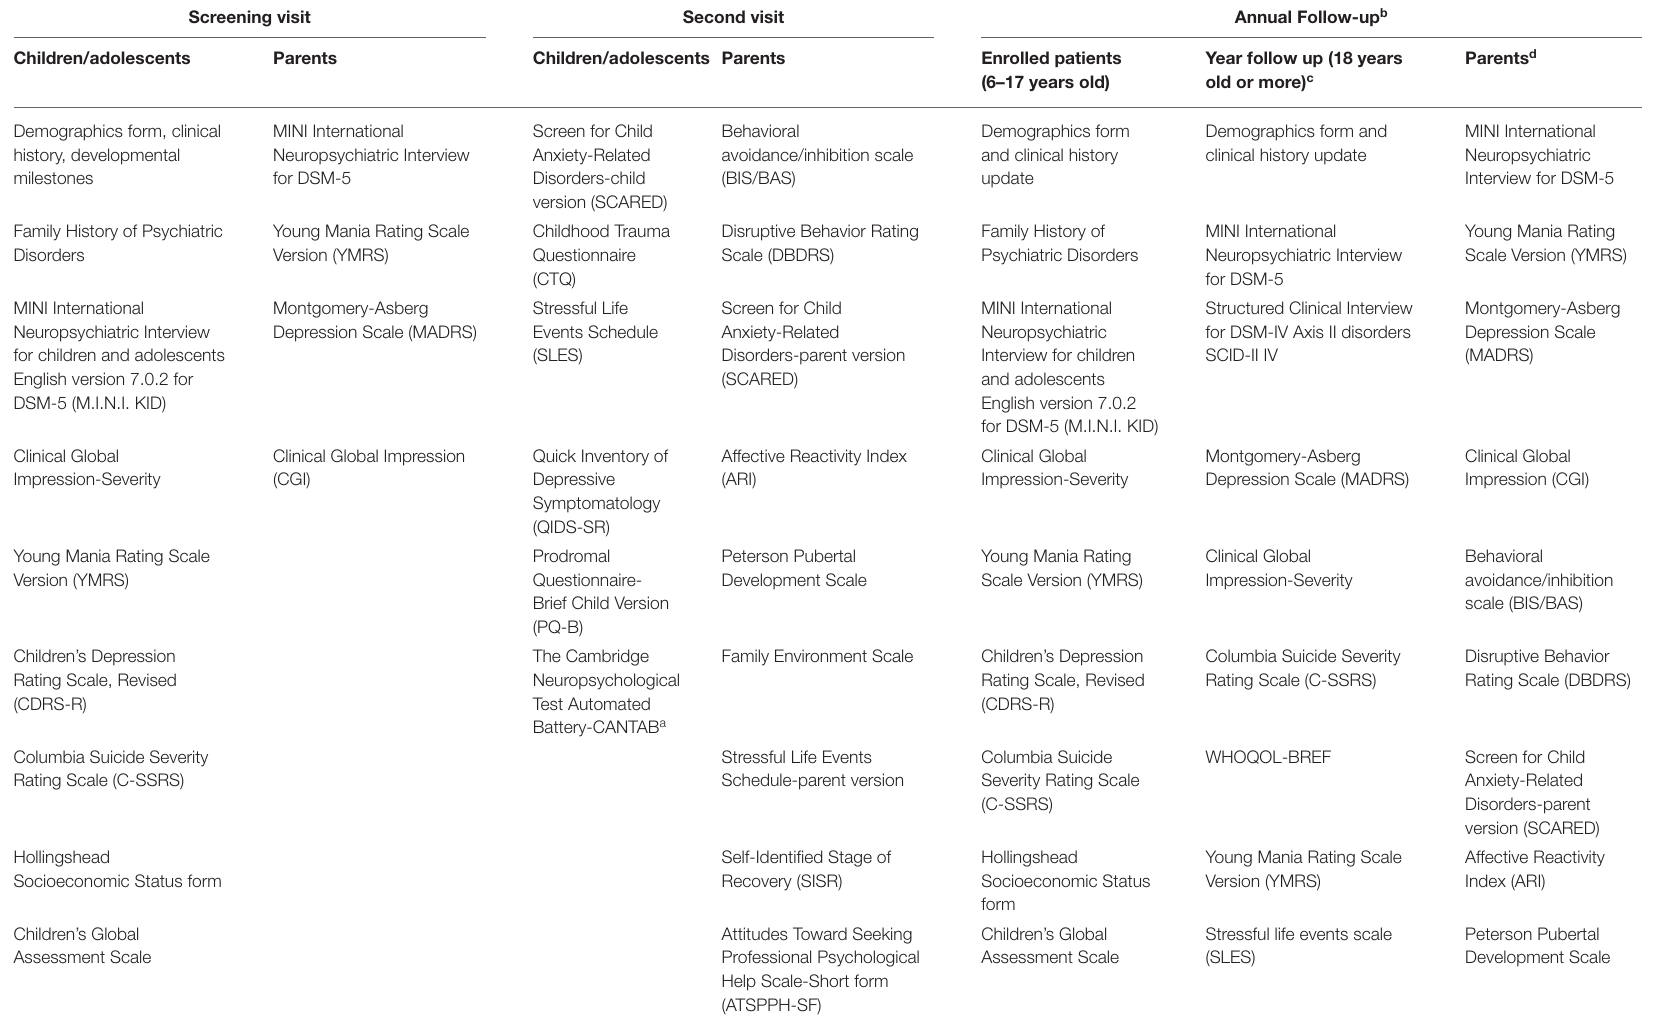
TABLE 2 | The greater Houston Area Bipolar Registry – demographics, family history of psychiatric disorders and clinical evaluation instruments according to the assessment. Screening